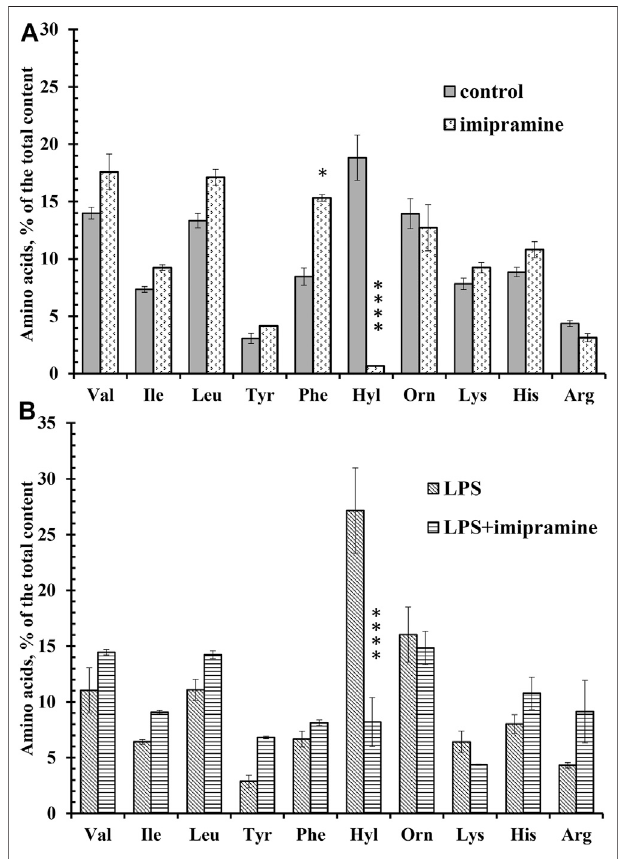
FIGURE 6 | Imipramine changed the composition of free amino acid secretion by neutrophils during adhesion. (A) Human neutrophils were attached to fi bronectin-coated substrata for 25 min under control conditions or in the presence of 100 μ M imipramine. The amount of amino acid is represented as a percentage of the total content of the detected free amino acids (mean ± SEM). Amino acid pro fi les were obtained by summing the results of three independent experiments. ****- signi fi cant differences when comparedtothevalueforthesameaminoacidinthecontrolcells( p < 0.0001) as indicated by a two-way ANOVA with a Tukey ’ s multiple comparisons test. (B) Human neutrophils were attached to fi bronectin-coated substrata for 25 min in the presence of 10 μ g/ml LPS or in the presence of 10 μ g/ml LPS and 100 μ M imipramine. The amount of amino acid is represented as a percentage of the total content of the detected free amino acids (mean ± SEM). Amino acid pro fi les were obtained by summing the results of three independent experiments. ****- signi fi cant differences when compared to the value for the same amino acid in the presence of LPS only ( p < 0.0001) as indicated by a two-way ANOVA with a Tukey ’ s multiple comparisons